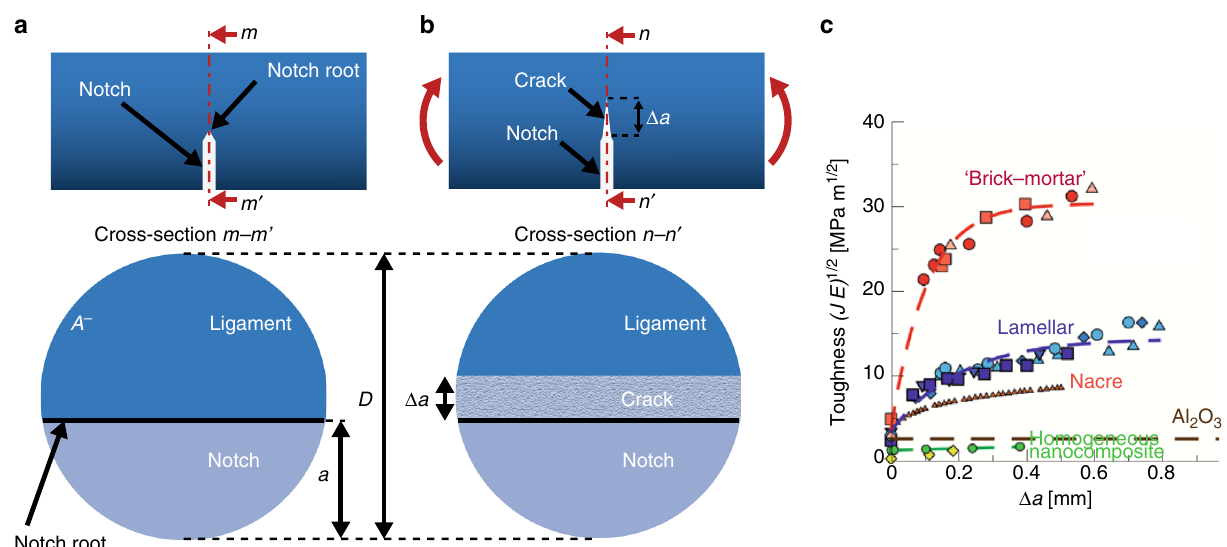
Fig. 3 Fracture toughness and crack growth from a notch. a Geometry of a fracture test specimen with a notch cut in it. A cross-sectional view shows the notch length, a , and ligament area, A − . b When loaded in fl exure, a crack grows from the notch root. The crack length, Δ a is shown in the corresponding cross-sectional view. c Crack growth resistance curves of nacre, nacre-inspired composites made of aluminum oxide tablets, and monolithic aluminum oxide obtained by 1 and 9 . The crack growth resistance is given here in terms of the J -integral (modi fi ed with permission from 1 copyright Nature Publishing Group).